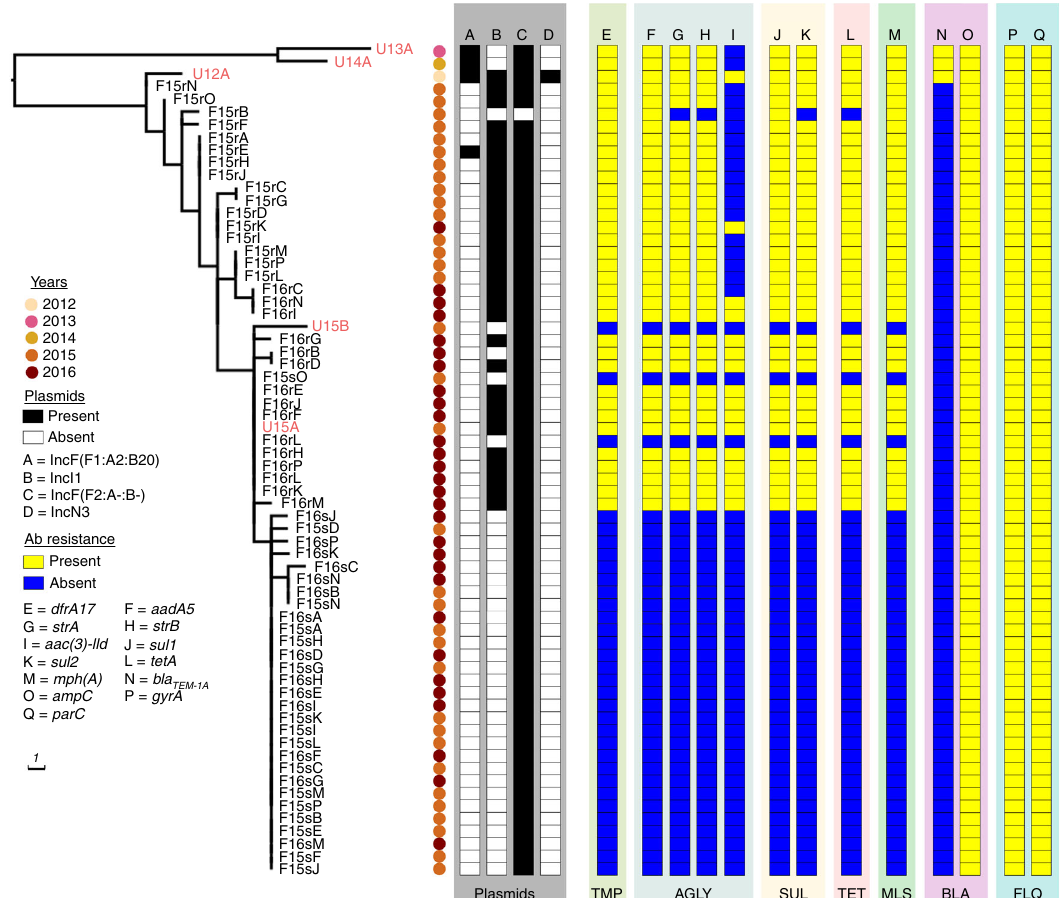
Fig. 4 Phylogeny of the 62 Patient #1 urine and faecal isolates. The presence or absence of typeable plasmids and antibiotic resistance genes is indicated as per the legend. Plasmid ’ s presence or absence was determined based on a BLASTn comparison of the assembled contigs for each strain using the complete plasmid sequences from U12A as a reference (Supplementary Fig. 2). Scale bar indicates branch length in number of single-nucleotide